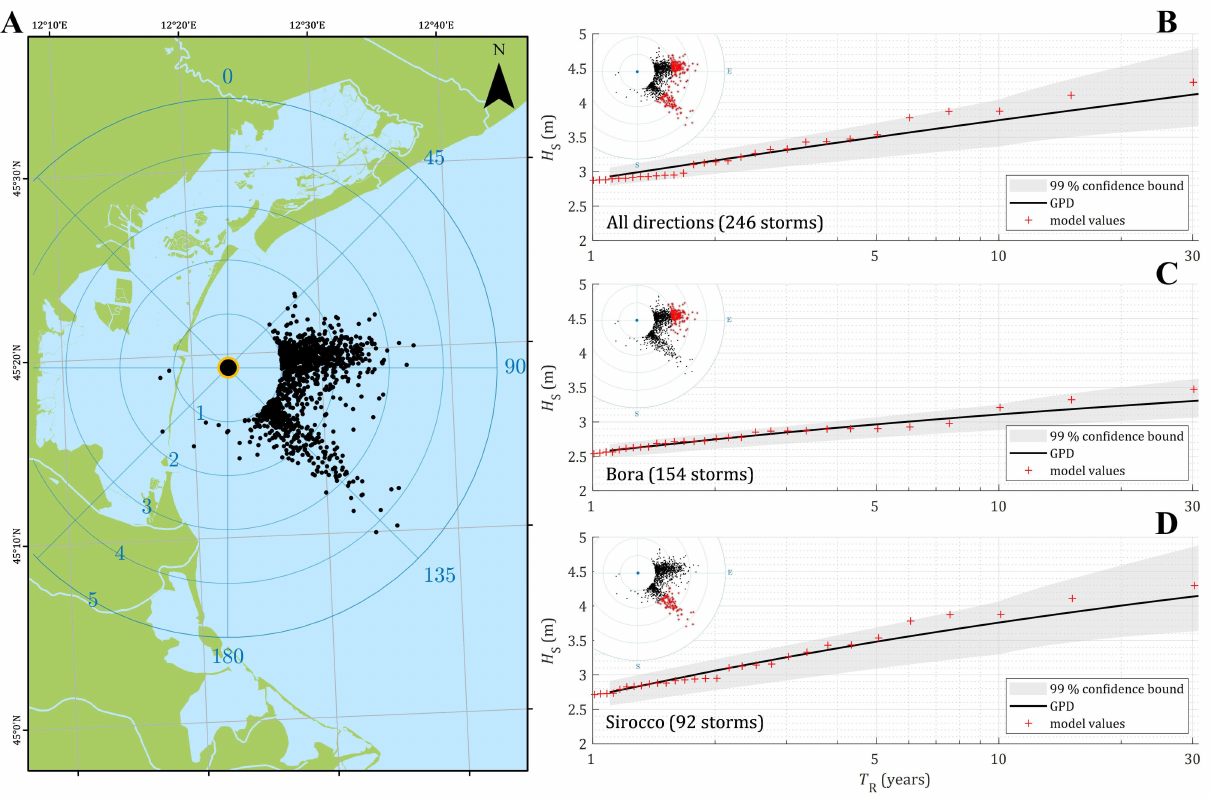
Figure 14. The long-term wave climate offshore the Venice lagoon (the northern Adriatic Sea; see Figure 1) for the present-day period 1981–2010. ( A ) Geographical position of the location of interest (black dot at the center of the polar grid) and distribution (small black dots) of H s (radius, discretized every 1 m) and peak direction of propagation (angle, clockwise from the north). The long-term distribution of the POT ranked H s values and associated empirical return periods T R (red crosses) for the overall sea states ( B ), Bora sea states ( C ), and Sirocco sea states ( D ). In the inset, the polar grid replicates with black dots the grid on panel ( A ), while the red dots identify the storms used for the extreme analysis of each dataset. The black line shows the generalized Pareto distribution (GPD) values and their confidence interval (shaded gray